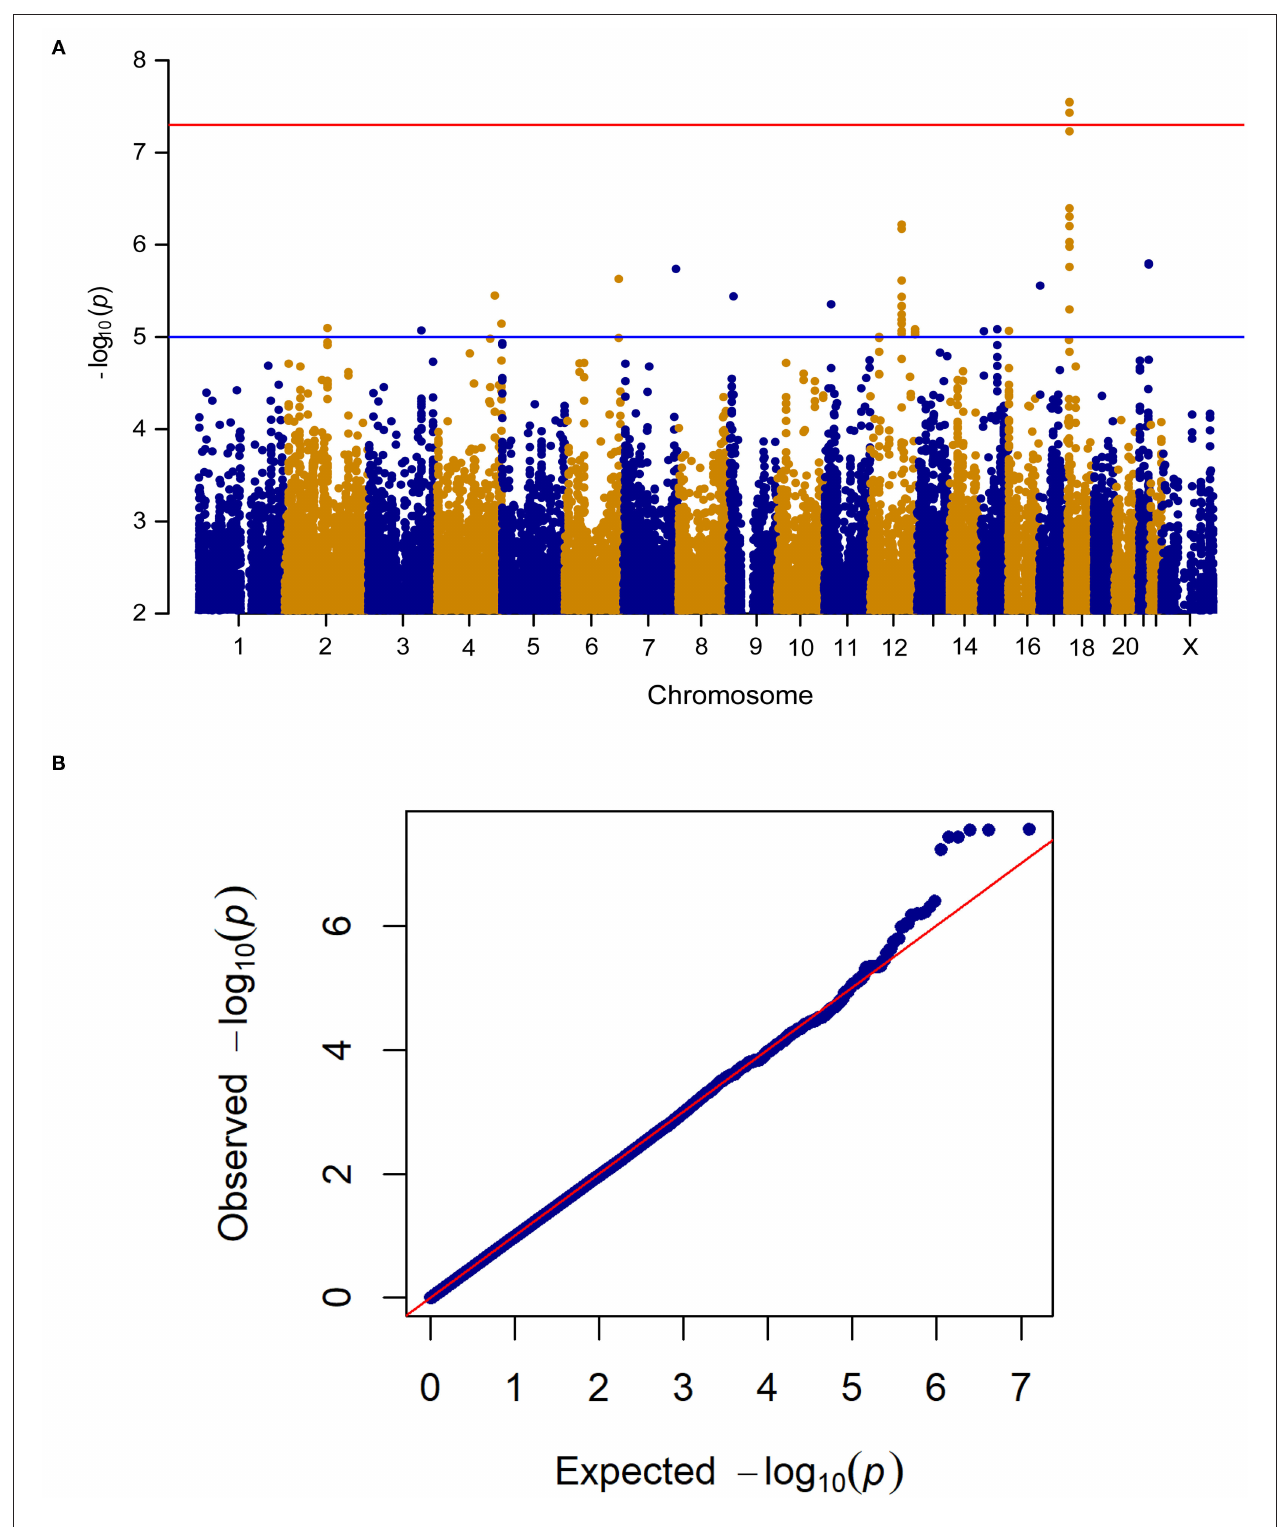
FIGURE 3 | (A) Manhattan plot of GWAS of change in pain frequency among 212 IBS patients controlling for age, sex, treatment arm and the first 5 principal components for genetic ancestry. The x-axis is chromosome position and the y-axis is p -value. The red line represents the “genome-wide significant” threshold, 5.0E-8, and the blue line denotes the “genome-wide suggestive” threshold, 1.0E-5. We find five genome-wide significant SNPs rs1105794, rs4479336, rs6506387, rs4798443, rs9952528, and a few genome-wide suggestive SNPs. (B) Quantile-quantile plot of the data. The genomic inflation factor λ is 0.989, which indicates that no inflation of data was observed in the GWAS of change in pain frequency from baseline to 6 weeks across all treatment arms.